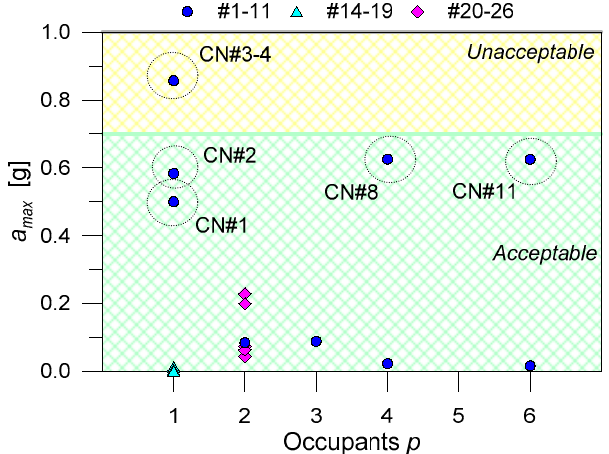
Figure 10. Vibration serviceability assessment of the examined system, based on EC0-A2 provisions. Experimental acceleration peaks (average values, vertical direction), as a function of the number of occupants.